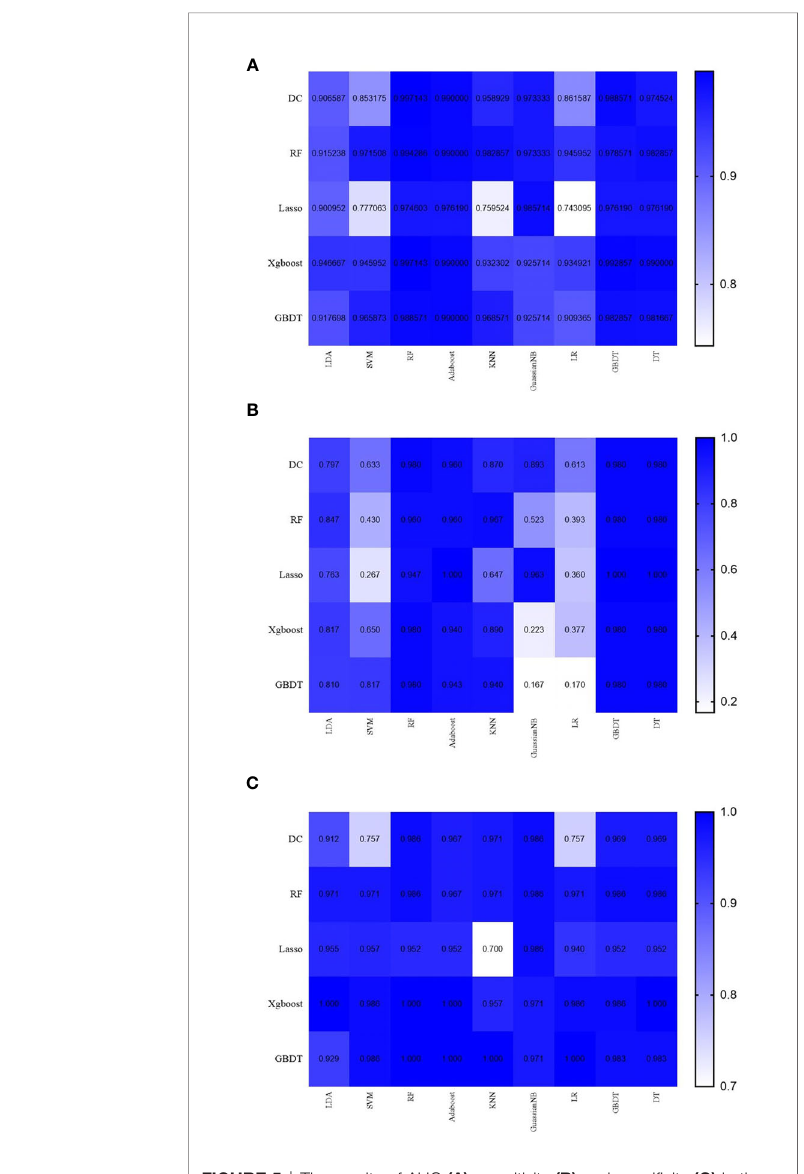
FIGURE 5 | The results of AUC (A) , sensitivity (B) and speci fi city (C) in the testing